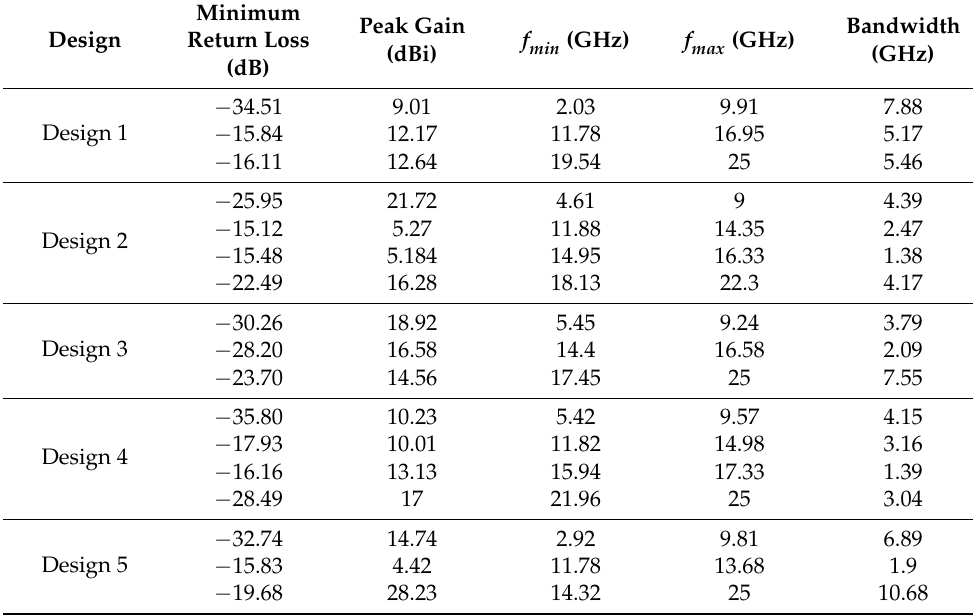
Table 3. Simulation based derived results and comparative analysis for the different antenna